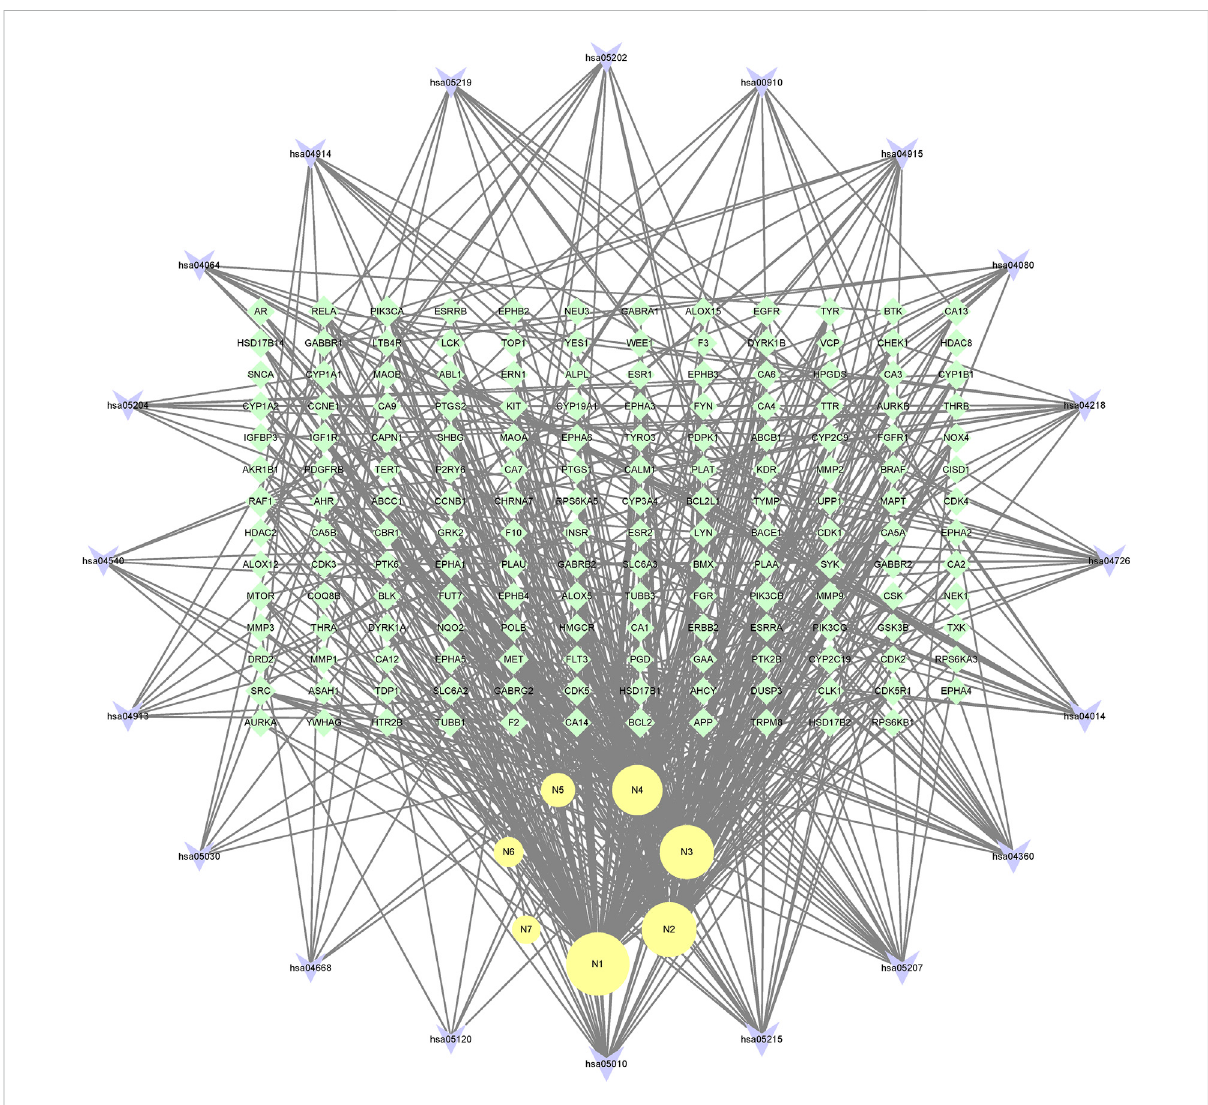
FIGURE 11 The metabolite-target-pathway network of mulberroside A